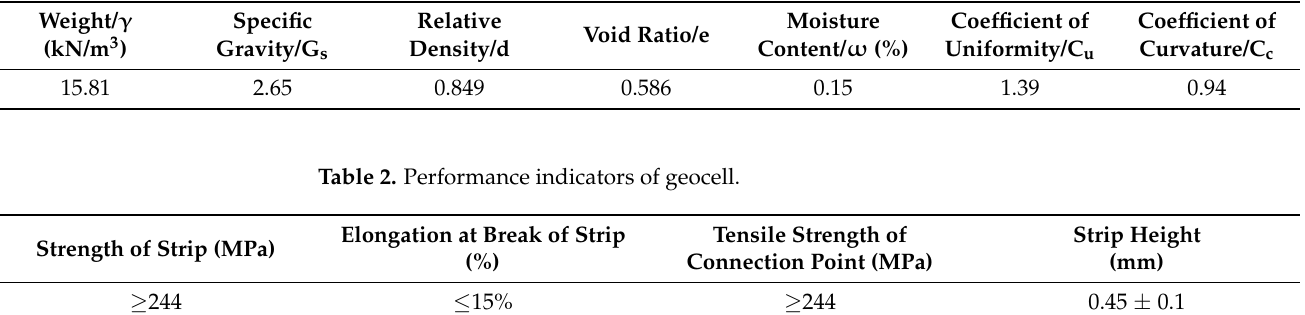
Table 1. Physical property indicators of sand.